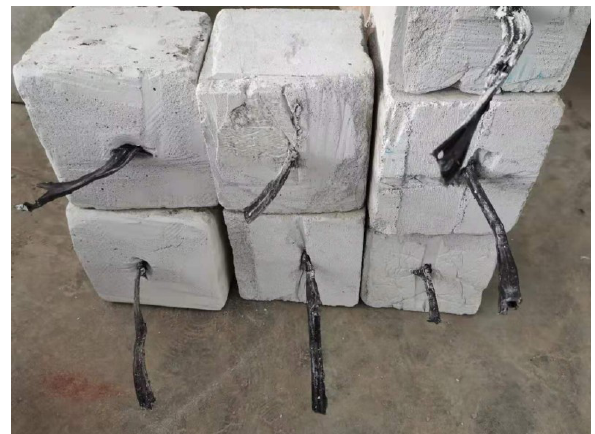
Figure 2: Pullout